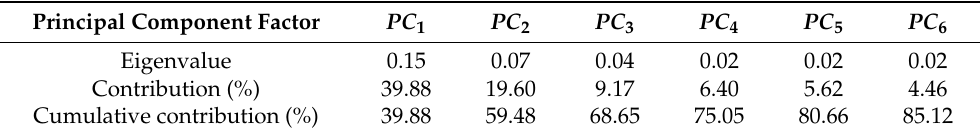
Table 3. The result of Spatial Principal Component